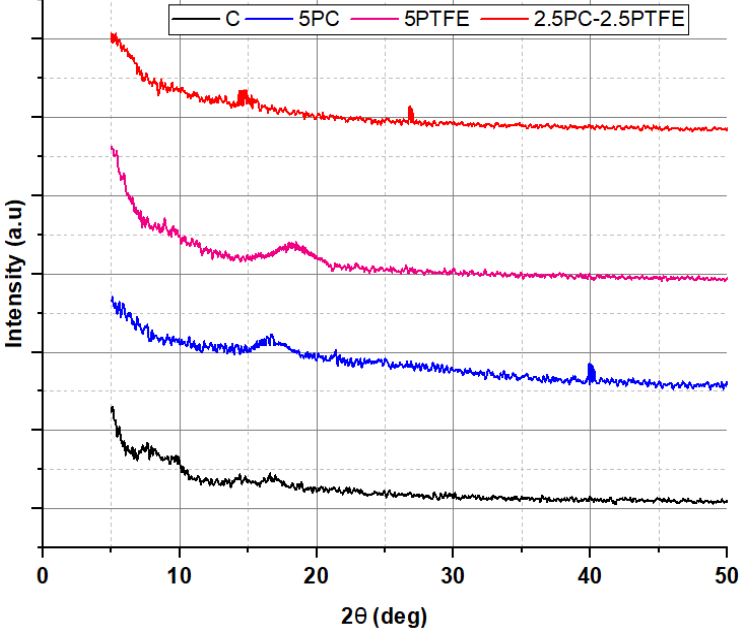
Figure 19. X-ray diffraction patterns of binders after aging.